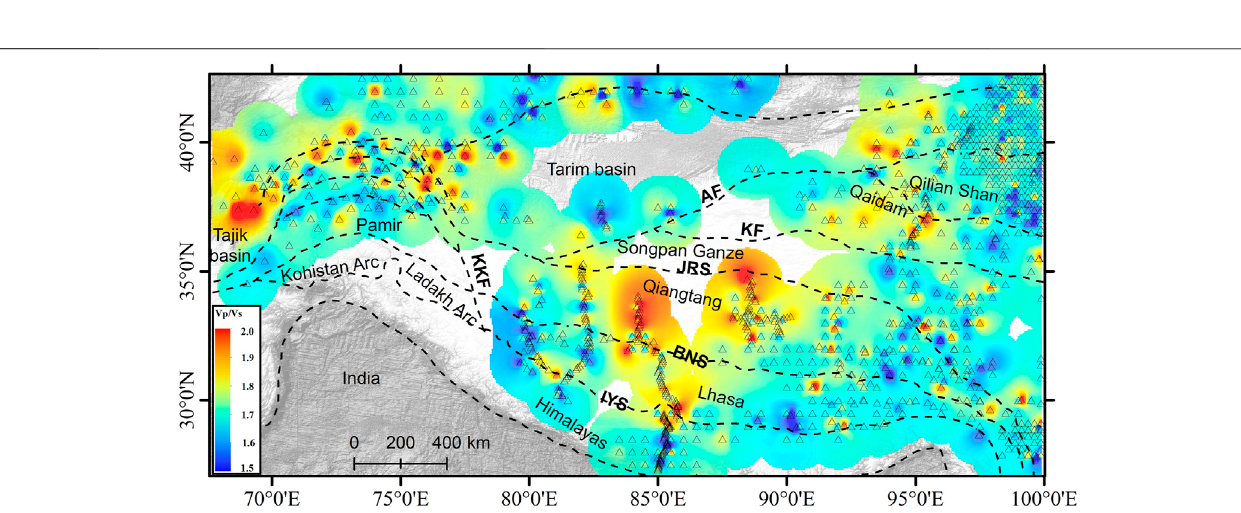
FIGURE 7 | Map of crustal Vp/Vs ratio variation beneath the Pamir – Tibetan plateau. The Vp/Vs ratio values have been obtained from receiver function analysis conducted across the Pamir and Tibetan plateau. The triangles indicate the locations of the stations. AF, Altyn-Tagh Fault; KF, Kunlun Fault; JRS, Jinsha River Suture; IYS, Indus Yarlung Suture; BNS, Bangong-Nujiang Suture; KKF, Karakorum Fault. The Vp/Vs ratio values beneath the Pamir plateau have been taken from published data of the TIPAGE (Schneider et al., 2019) and East Pamir seismic experiment (Xu et al., 2021). Beneath the Tibetan plateau, we have used the Vp/Vs ratio values derivedfromthereceiverfunctionsalongHi-CLIMB(LiJ.andSongX.,2021),NamcheBarwaProject(Xuetal.,2013),ANTILOPE-IandII(Xuetal.,2014;Xuetal.,2017; Murodov et al., 2018), TW-80 (Zhang et al., 2014), INDEPTH (Yue et al., 2012), (Tian and Zhang, 2013; He et al., 2014; Cheng et al., 2021).